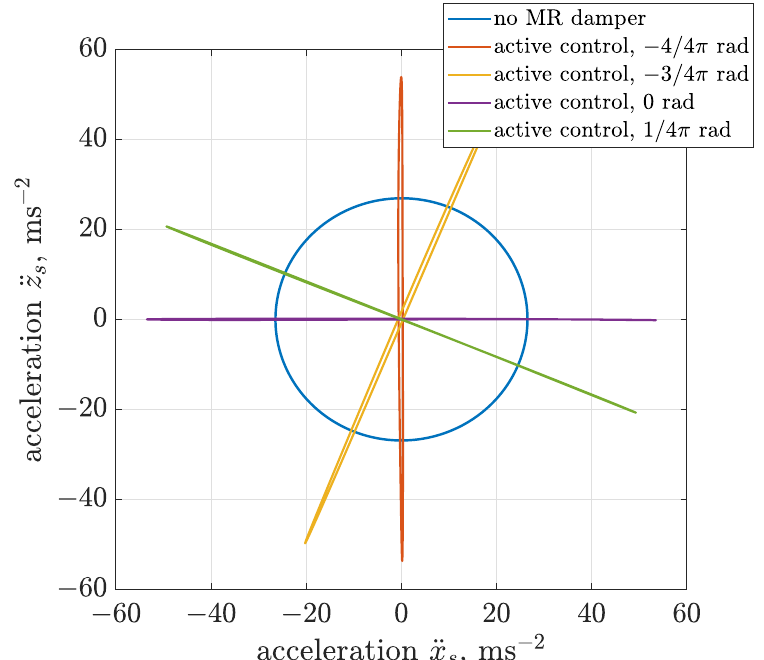
Figure 22. Different configurations of phase shift ∆ α alg dedicated to active generation of linear trajectories of vibration acceleration.